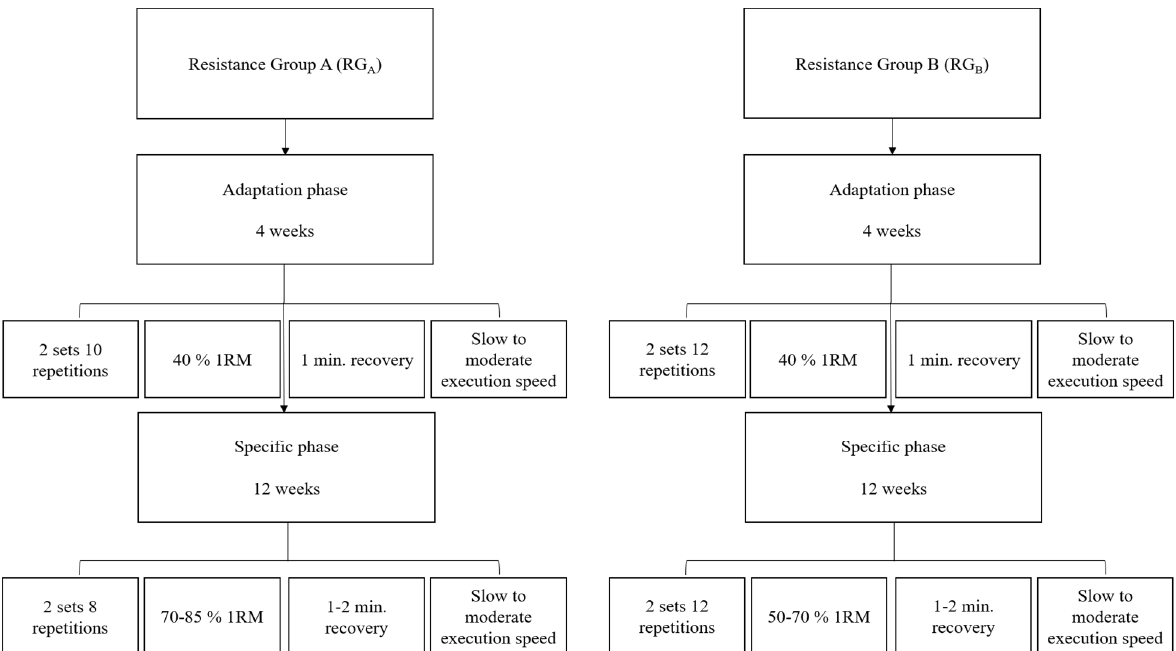
Figure 2. Schematic design of the experimental protocol.